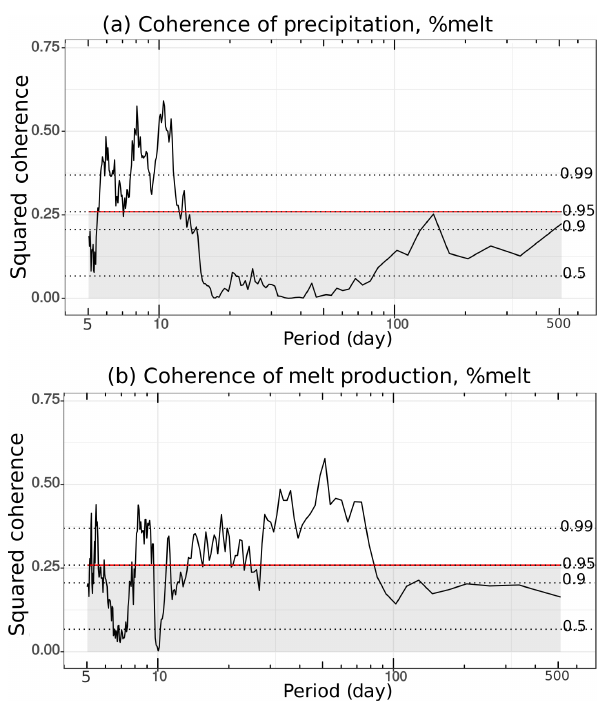
Figure 8. Magnitude squared coherences between simulated per- cent glacier melt contribution to discharge with (a) precipitation and (b) simulated glacier melt production. Calculations used daily average data to avoid known uncertainties in modeling diurnal fluc- tuations of glacier melt production. Precipitation and glacier melt production appear to be related to glacier melt contributions at com- plementary